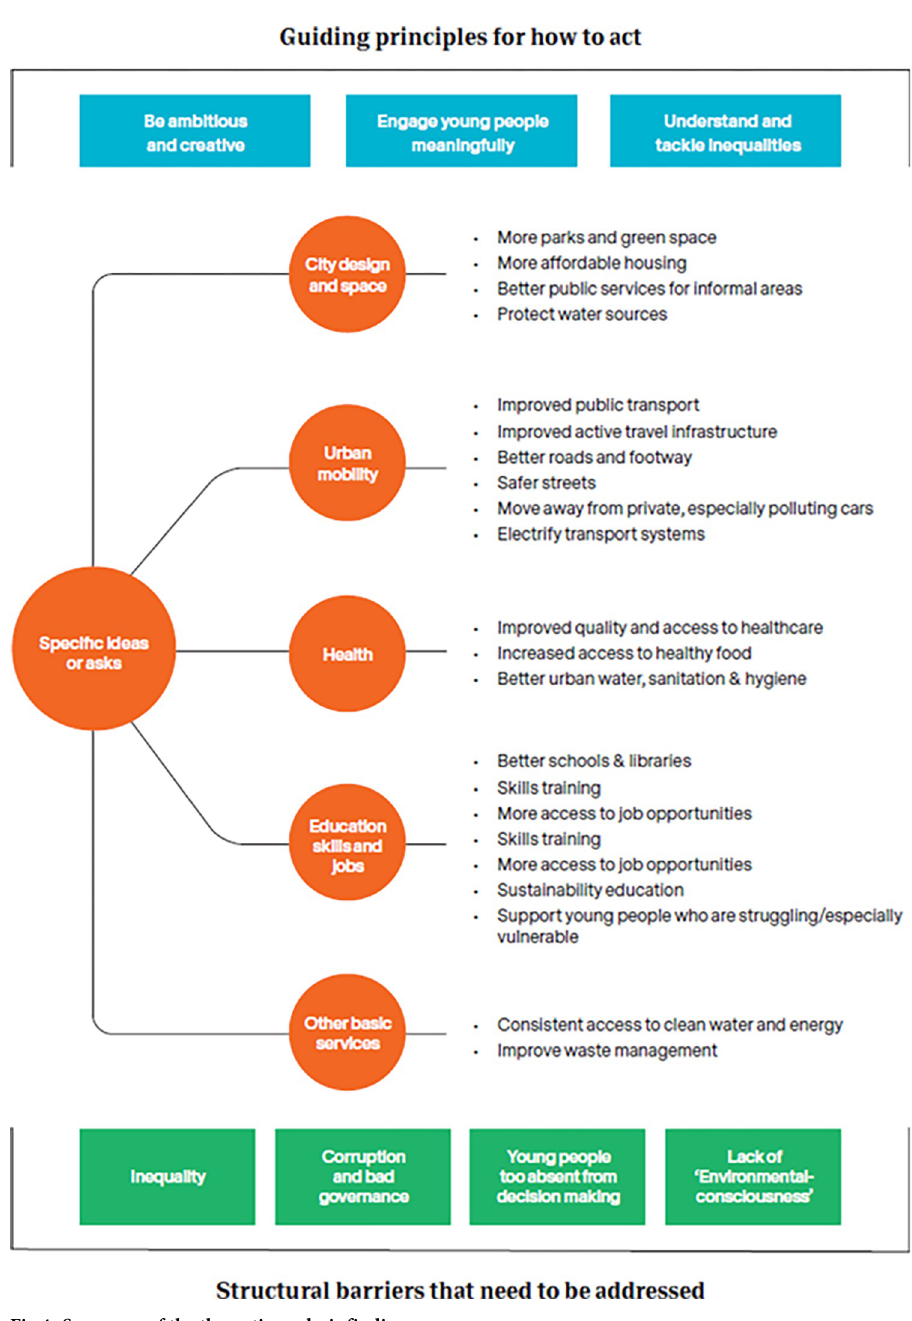
Fig 4. Summary of the thematic analysis